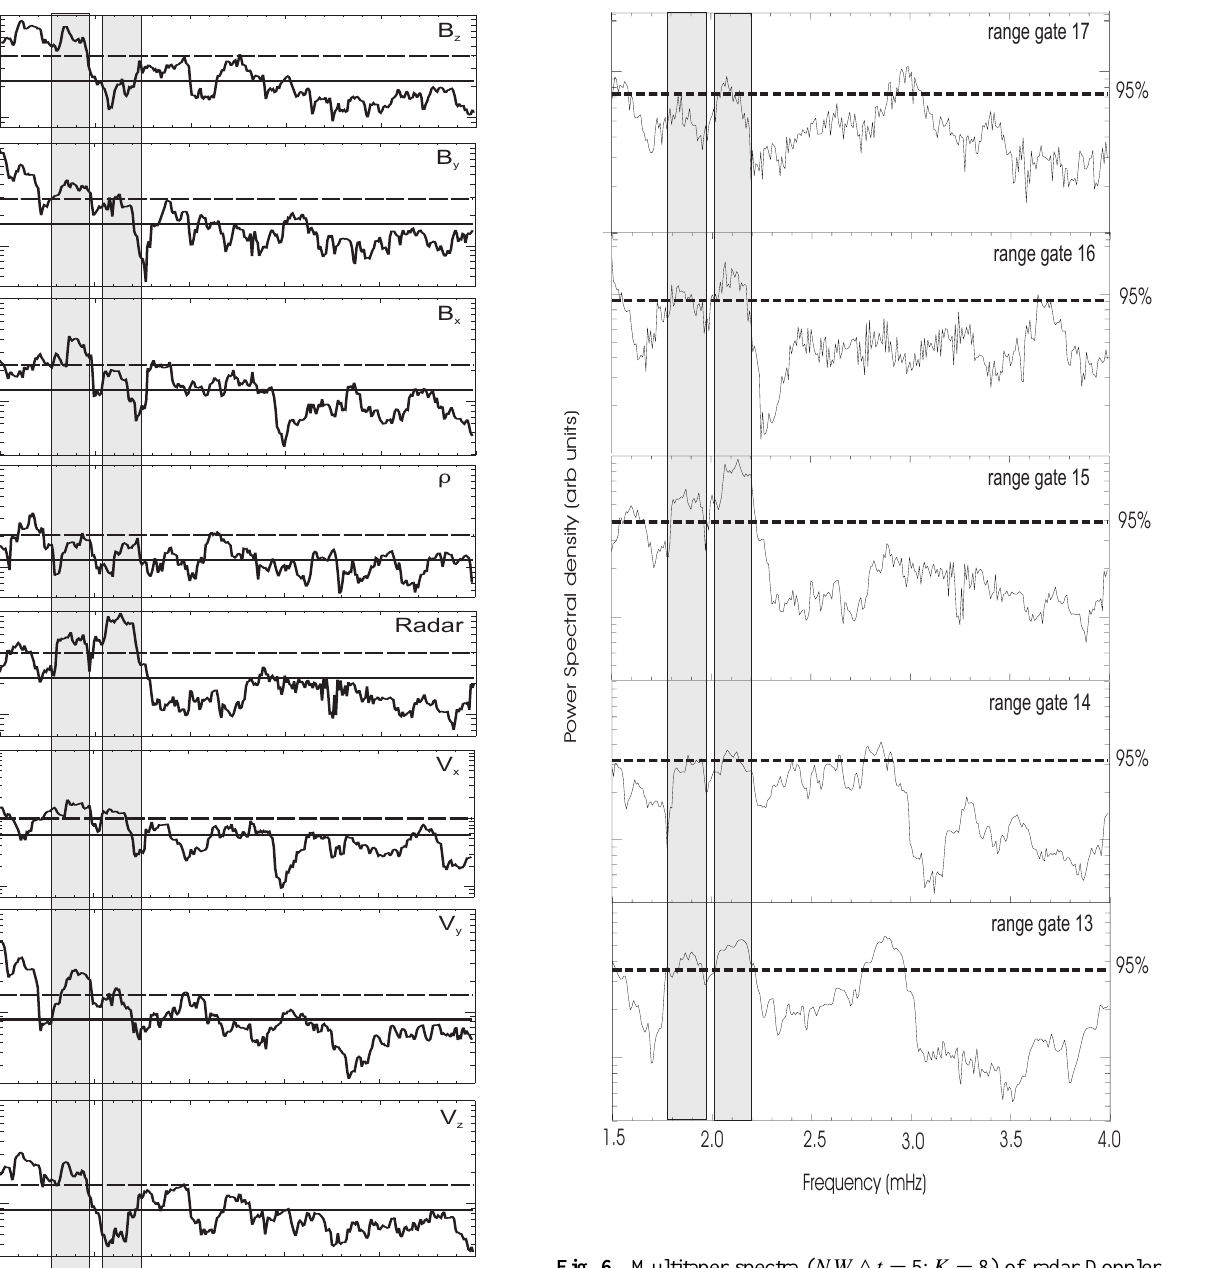
Fig. 6. Multitaper spectra ( NW 4 t = 5 ; K = 8) of radar Doppler velocity beam 4 range gates 13–17 on 7 June 2000. Data intervals for each gate are variable depending on data